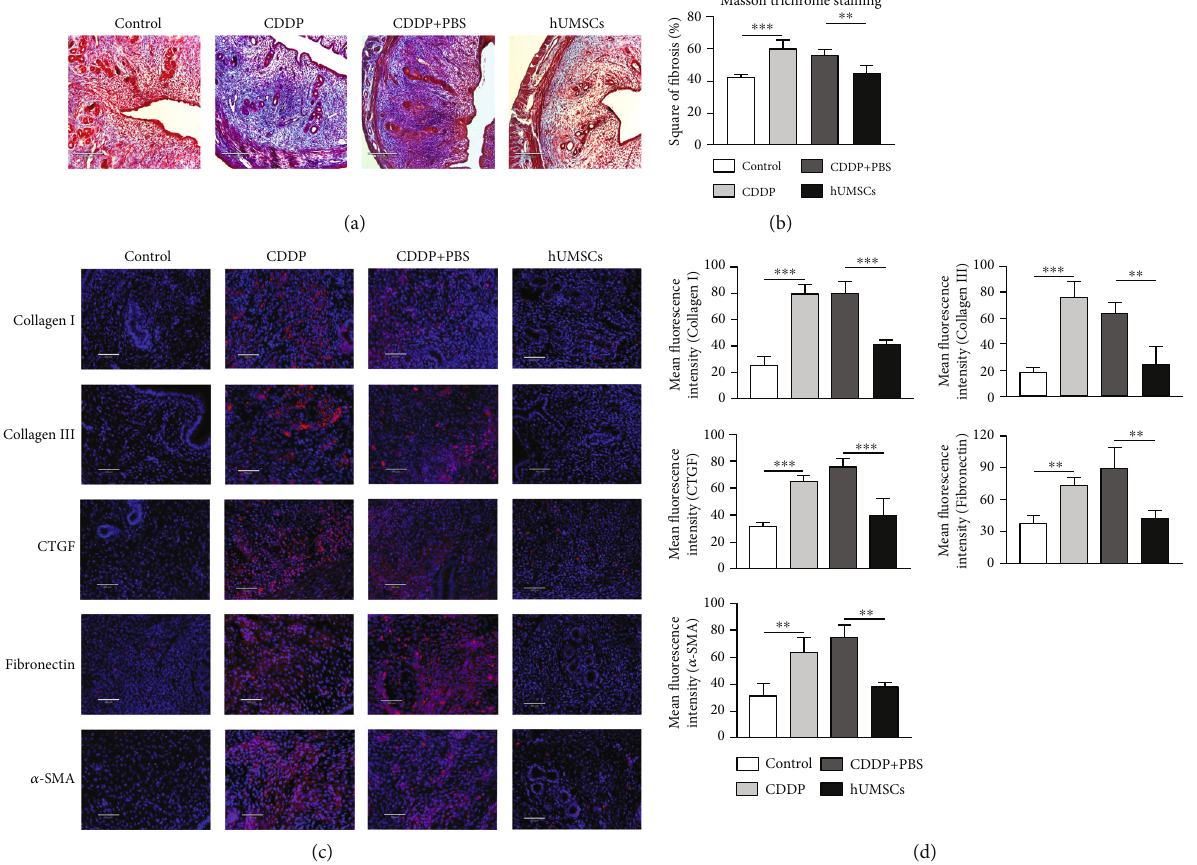
Figure 3: Histopathological analysis of uterine fi brosis. (a) Masson trichrome staining of uterine tissue in each group as observed under microscopy (100x). (b) Masson trichrome staining scores were quantitated using ImageJ software. (c) Immuno fl uorescent staining of Collagen I, Collagen III, CTGF, Fibronectin, and α -SMA expressions in uterine tissues of each group (200x). (d) Mean fl uorescent intensities as analyzed by ImageJ software. Data are presented as the means ± SDs . ∗ P < 0 : 05, ∗∗ P < 0 : 01, and ∗∗∗ P < 0 : 001 . CDDP: cisplatin; Collagen I: Collagen Type I; Collagen III: Collagen Type III; CTGF: connective tissue growth factor; α -SMA: alpha smooth muscle